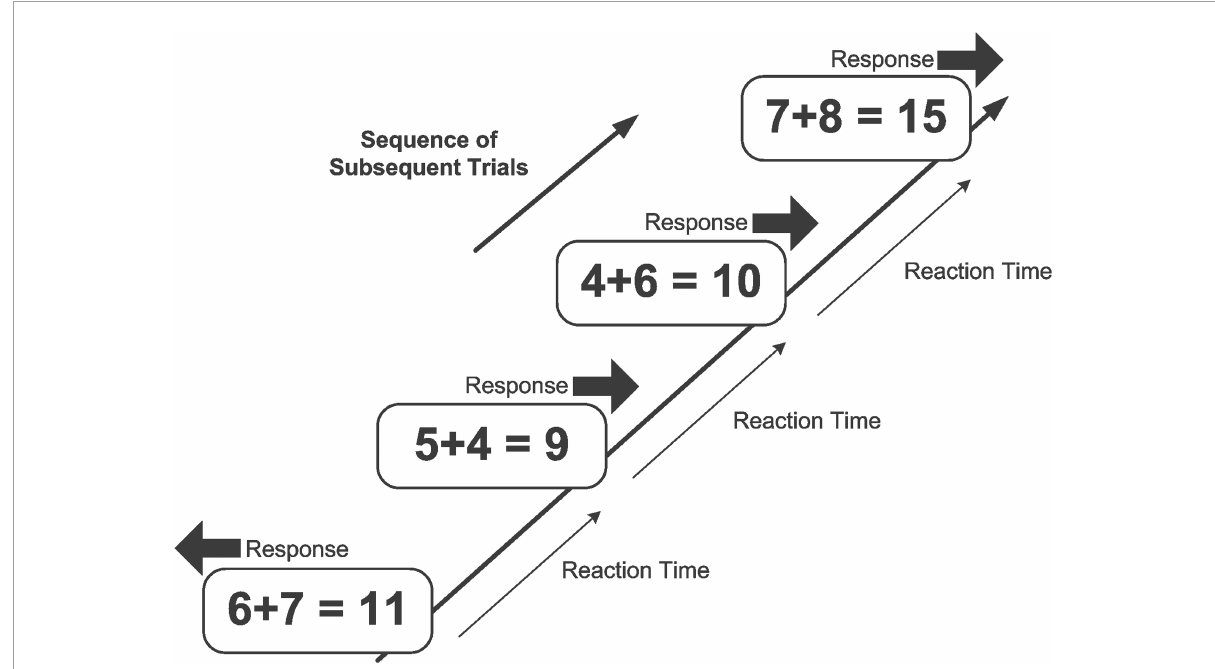
FIGURE1 Example of a series of trials in the mental addition and verification task. Participants have to perform an addition operation (e.g., “3 + 4 =”) and then to verify (or falsify) the correctness of their mental result with the presented addition term (e.g., “7 = 7”), by pressing the right (or left) response key. The task is self-paced such that each item is presented immediately after the response to the previous